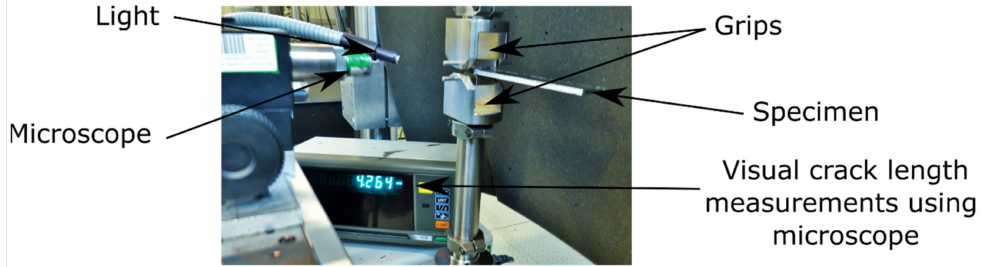
Figure 2. Test setup of the fatigue mode I double cantilever beam (DCB)